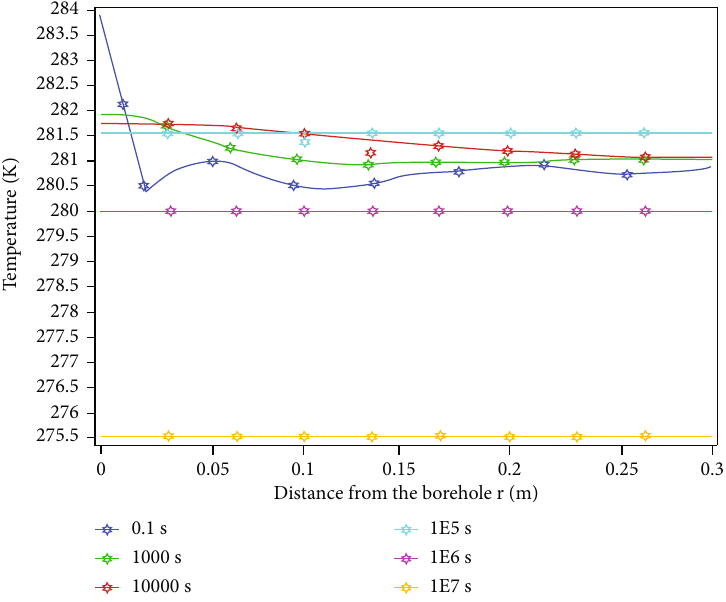
Figure 14: Temperature in the m = 7 coal rock during CBM